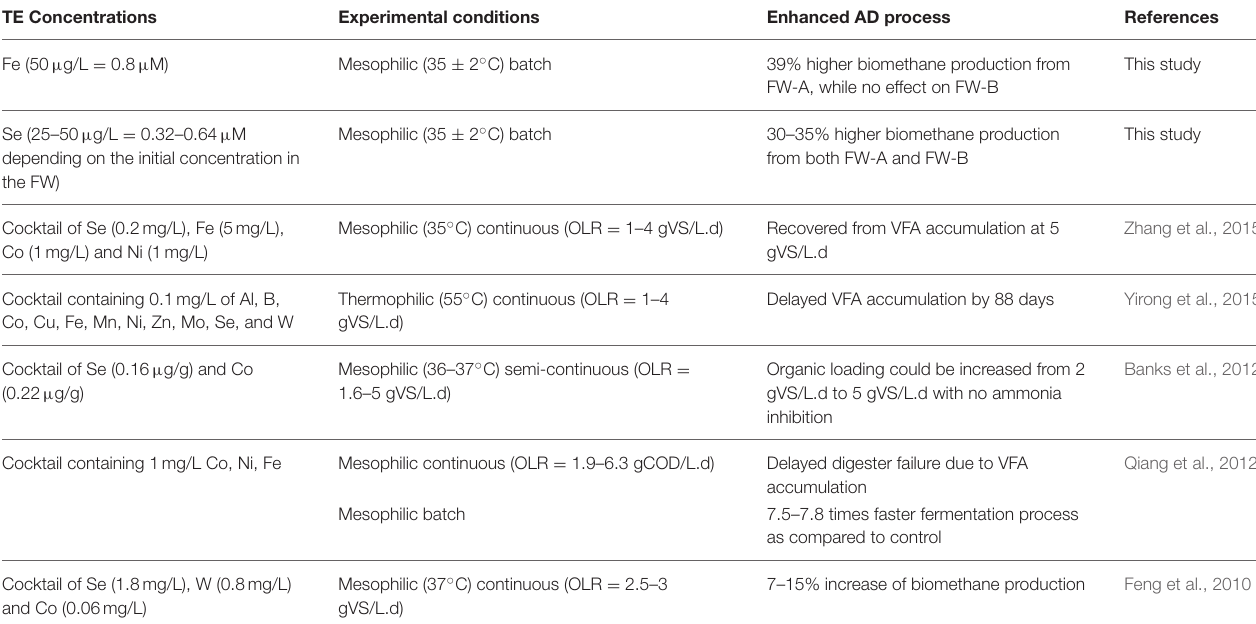
TABLE 4 | Enhanced AD of FW by supplementing